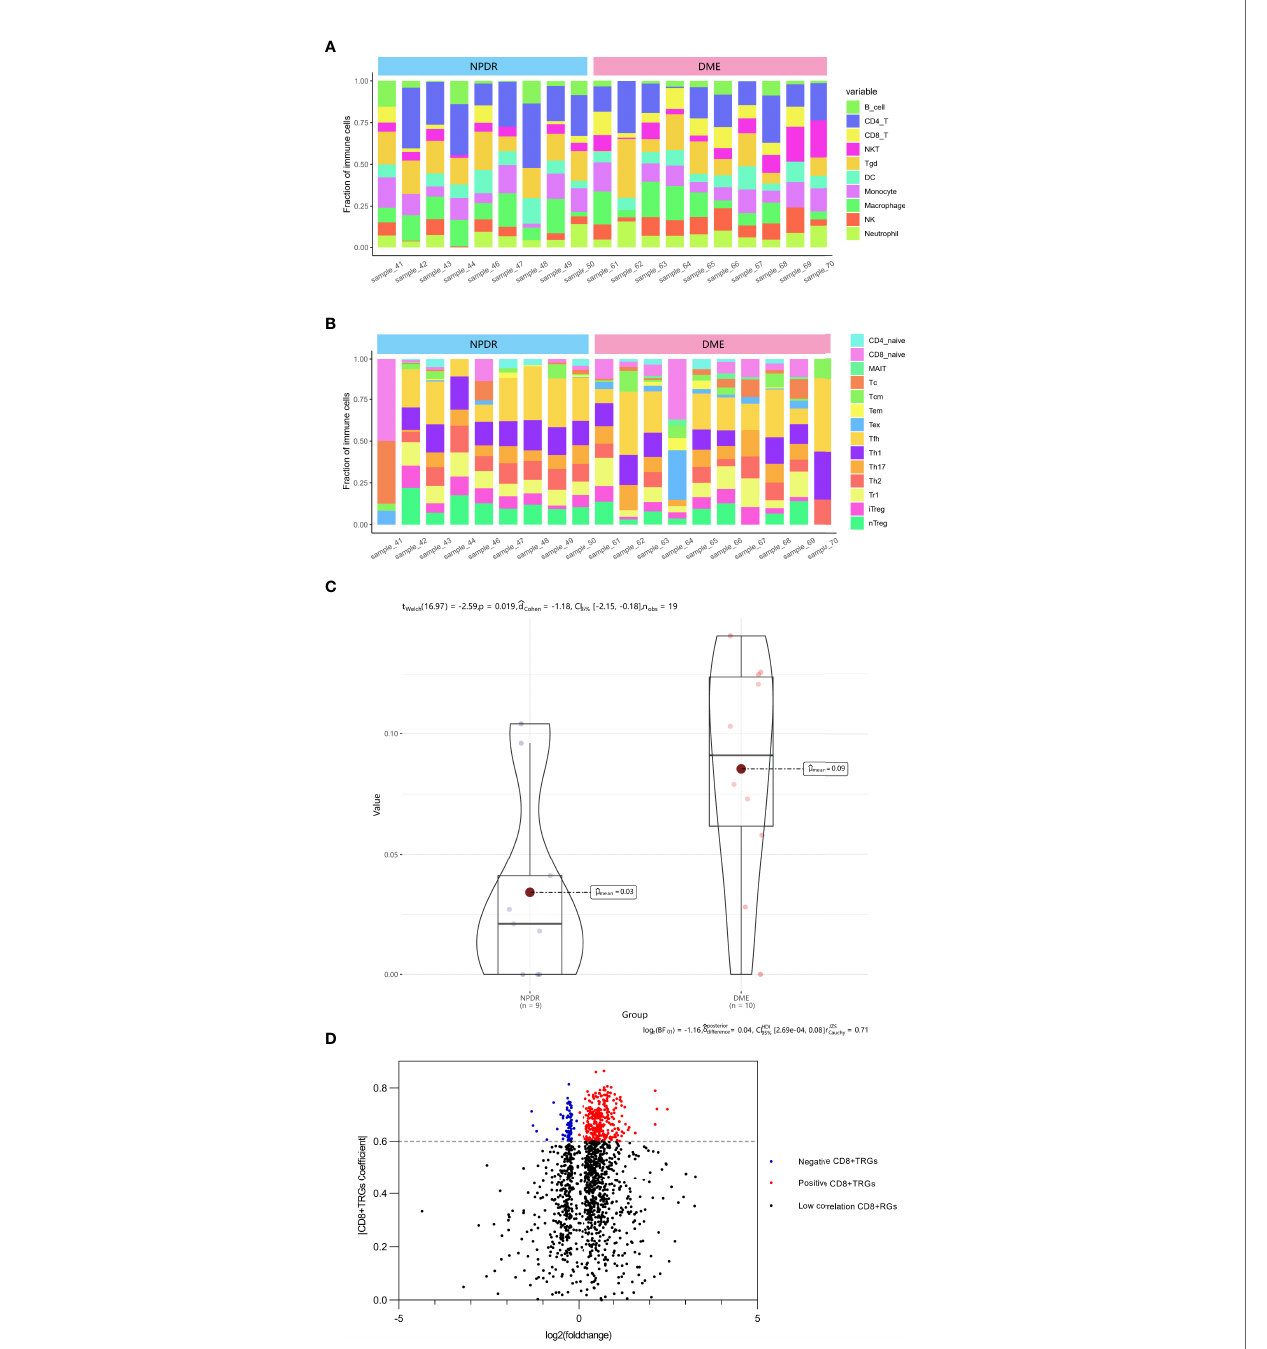
FIGURE 1 | Identi fi cation of DECD8+TRGs in macula from DR patients at NPDR stage and DME stage. (A, B) The abundance of 24 kinds of immune cells in 19 samples evaluated by ImmucellAI algorithm. (C) Overall CD8+T cell proportions comparison between 9 NPDR and 10 DME samples. (D) The volcano plot of differentially expressed genes between 9 NPDR and 10 DME samples. DECD8+TRGs, differentially expressed CD8+T cell related genes, CD8+TRGs, CD8+T cell related genes.